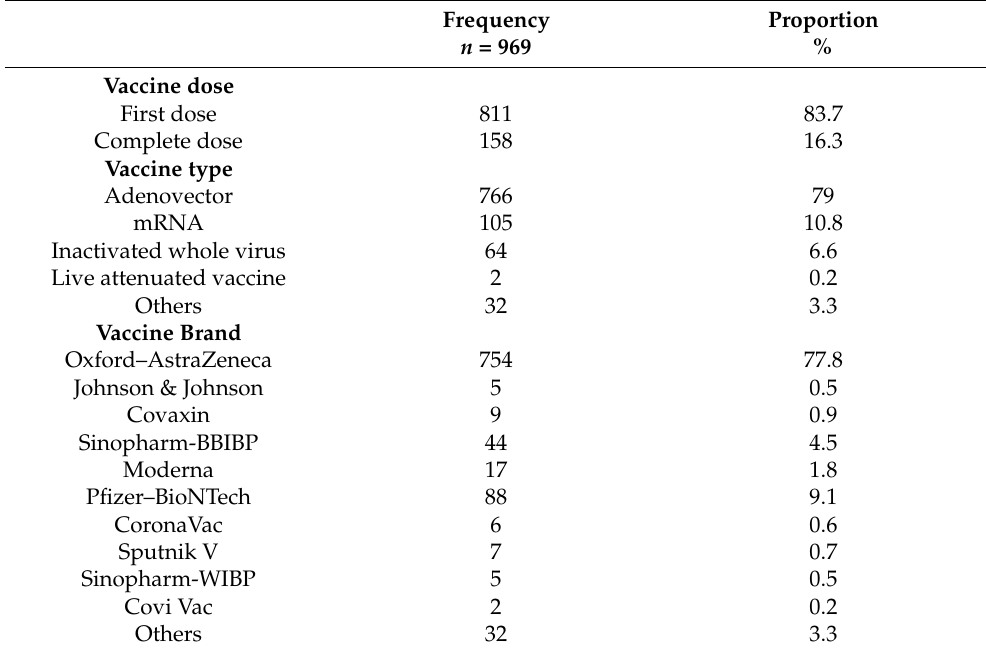
Table 4. Vaccine dose and types administered for COVID-19 in